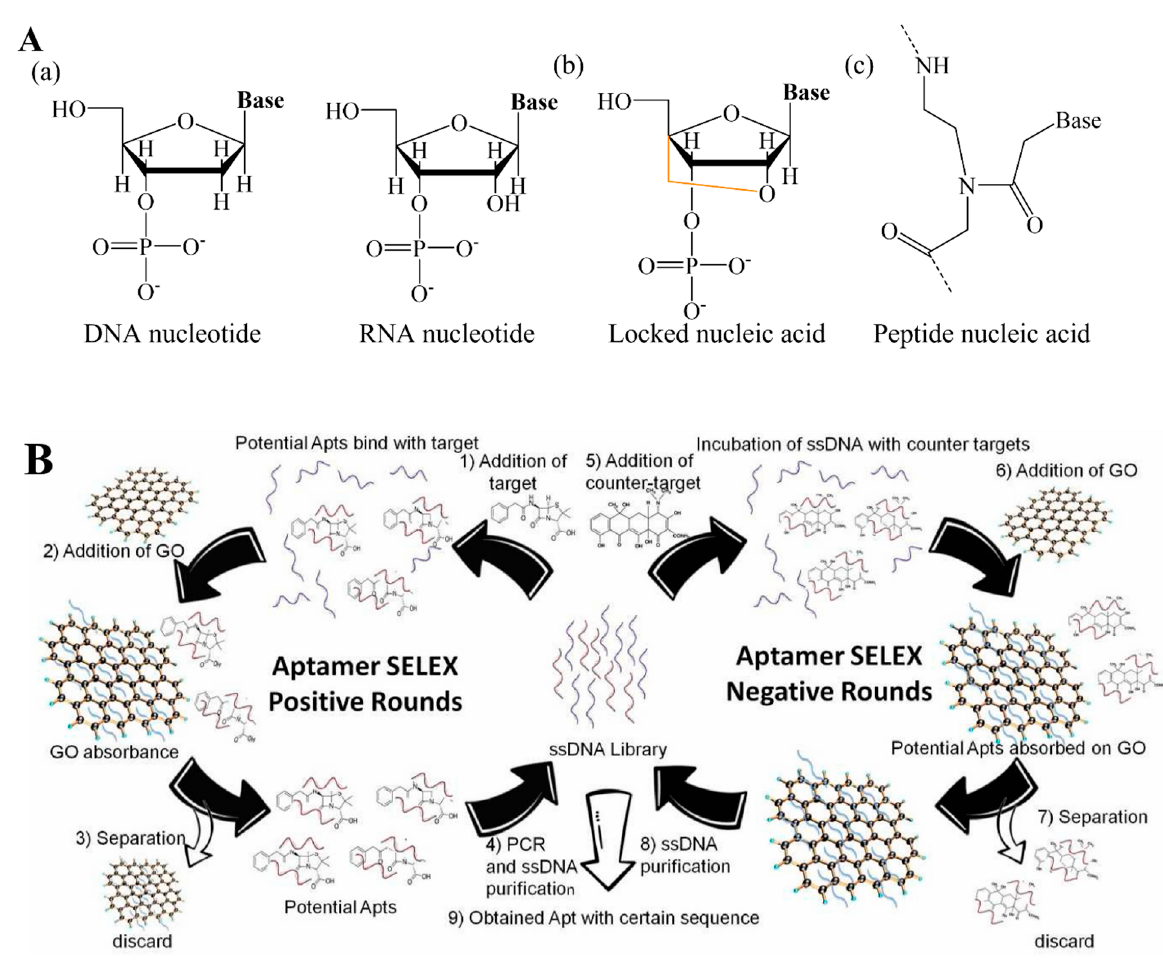
Figure 4. ( A ) Chemical structures of nucleic acids: ( a ) DNA and RNA nucleotide, ( b ) locked nucleic acid, ( c ) peptide nucleic acid. ( B ) Schematic illustration of aptamer selection by positive and negative SELEX methods. Reproduced with permission from Ref. [60]. Copyright 2022, Elsevier.